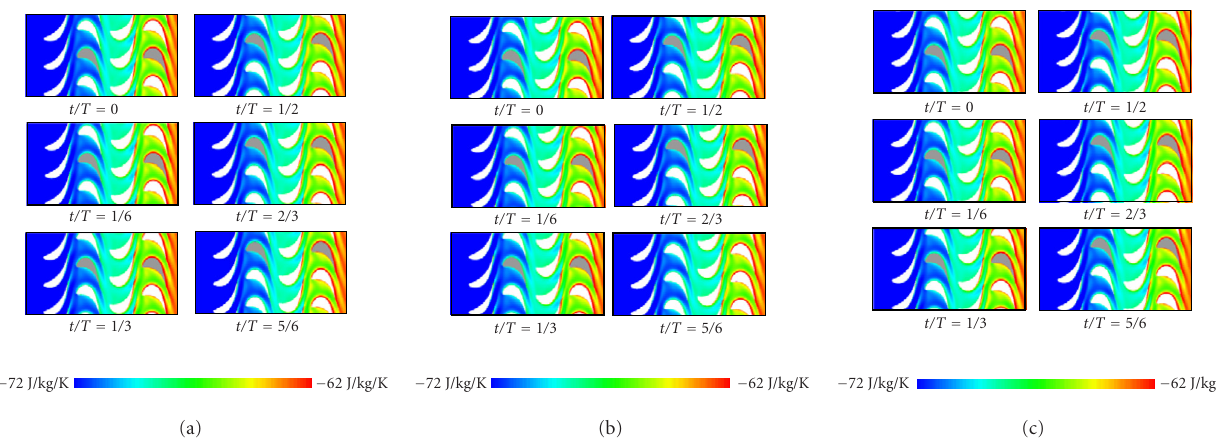
Figure 4: Entropy distributions in the unsteady calculation (sliding mesh approach): (a) clocking position s1, (b) clocking position s2, and (c) clocking position